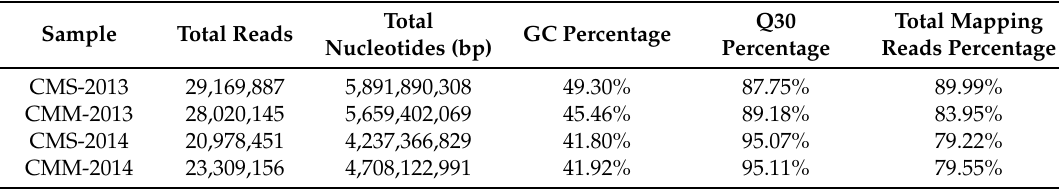
Table 1. Output statistics of sequencing